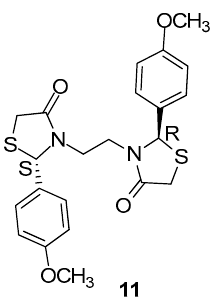
Figure 14. Chemical structure of 4-thiazolidinone derivative 11 .